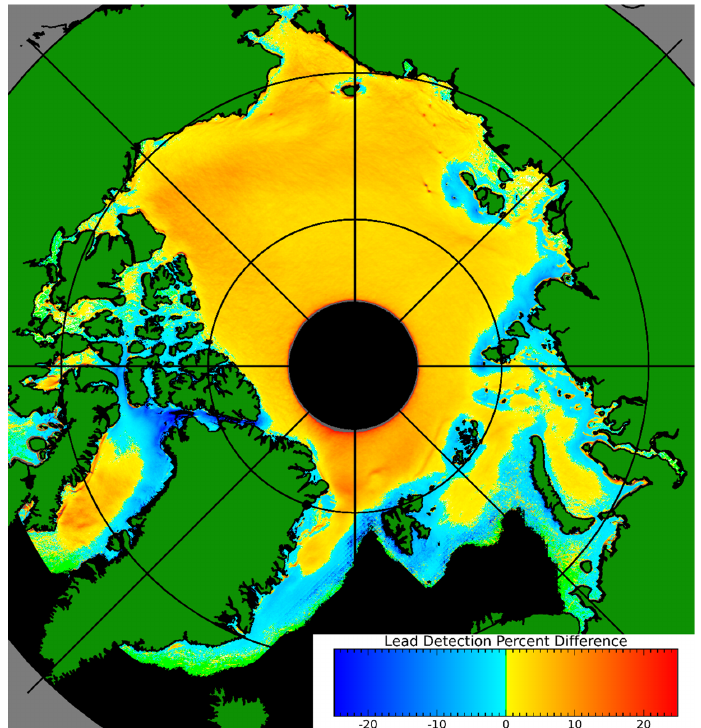
Figure 12. Comparison of the relative detection frequency between the AI-based lead detection [25] and legacy [12] and products. Lead products from November through April 2002–2022. Yellows and reds are used where the AI detection rate is higher, blue where legacy is higher, green indicates regions with identical detection rates, and black is outside of the ice pack. Willmes and Heinemann have a published dataset [24] of leads from January to April of 2003 through 2015. A comparison with the AI product [25] over the same time period is shown in Figure 13. Our new technique, again, has a slightly higher detection rate al- most everywhere inside the pack ice, whereas the Willmes and Heinemann technique has a higher detection rate in the marginal ice zones. This is further evidence that the AI prod- uct [25] does well at detecting leads within the continuous sea ice pack, but detection per- formance decreases in the marginal ice zone where it becomes more difficult to differen- tiate between leads and ice floes, as the leads become wider and faster moving.